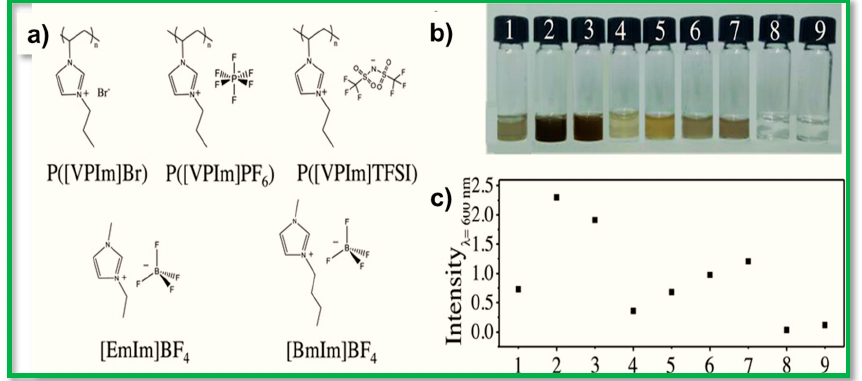
Figure 16. ( a ) Structure details of the employed PILs and ILs. ( b ) Photographs of BP suspensions exfoliated with different solvents (the supernatant after a centrifugation for 10 min at 3000 rpm). ( c ) Comparison of absorption intensity (wavelength at 600 nm) of BP solutions exfoliated with different solvents. ( a , b ) 1 to 9 stand for water + P([VPIm]Br) ( ≈ 3.49 mg mL − 1 ), DMF + P([VPIm]TFSI) ( ≈ 7.61 mg mL − 1 ), DMF + P([VPIm]PF6) ( ≈ 13.01 mg mL − 1 ), water, DMF, [EmIm]BF4, [BmIm]BF4, water + [EmIm]BF4 ( v / v = 5/1) and water + [BmIm]BF4 ( v / v = 5/1), respectively. Copyright 2018, WILEY-VCH Verlag GmbH & Co. KGaA, Weinheim, Reproduced with permission from Adv. Funct. Mater. [133], Copyright 2018, WILEY-VCH Verlag GmbH & Co. KGaA.